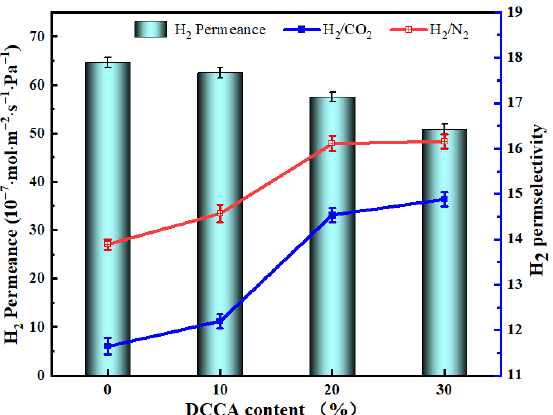
Figure 15. H 2 permeances and permselectivities of ZrO 2 -MSiO 2 membranes (n Zr = 0.15) with various DCCA additions at 200 °C and 0.1 MPa.